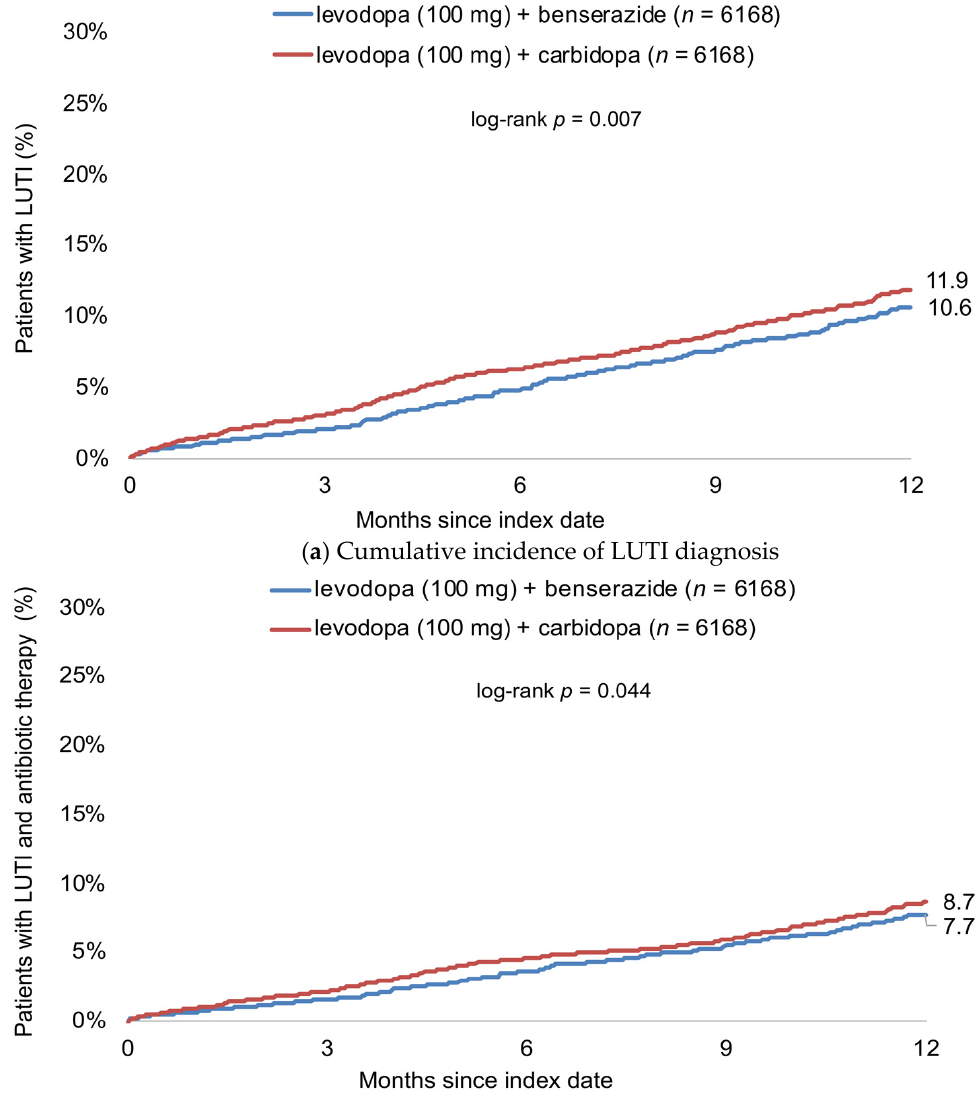
Figure 2. Cumulative incidence of LUTI diagnosis ( a ) and antibiotic therapy ( b ) within 12 months after start of therapy in patients treated with levodopa (100 mg) + benserazide and levodopa (100 mg) + carbidopa .